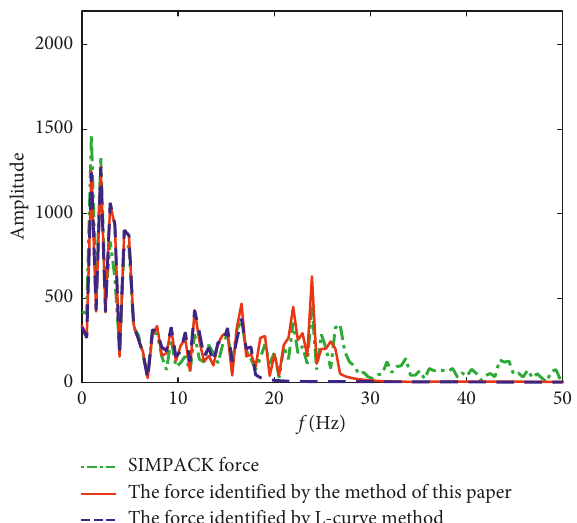
Figure 11: Amplitude-frequency curve of the two methods for F identification when the noise level is 5%.